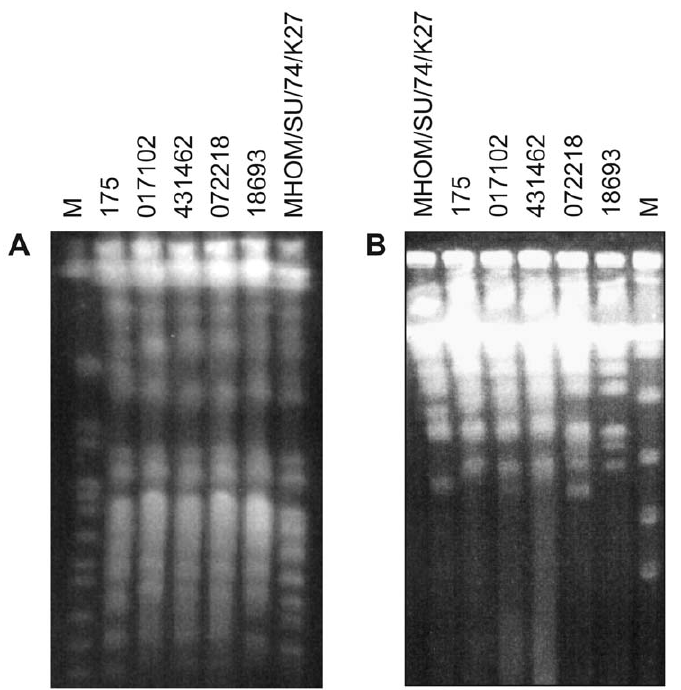
Figure 1. Karyotypes of Afghan and Iranian Leishmaniatropica isolates as characterized by PFGE. Cells were embedded and lyzed in agarose and their chromosomes were electrophoresed and stained with ethidium bromide. A. 600–1300 kb electrophoresis B. 100–500 kb electrophoresis. The field isolates 017102, 431462, 072218 and 18693 from Afghanistan have closely related karyotype to the L. tropica reference strains 175 and MHOM/SU/74/K27. M, yeast chromosomes molecular weight marker (BioRad).